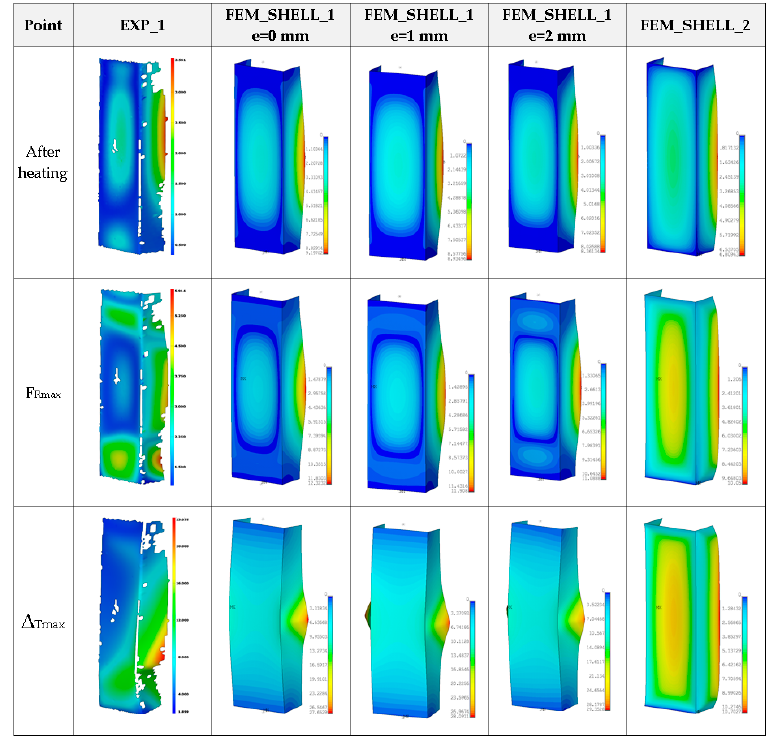
Figure 23. The compression curves of column at 150 °C.